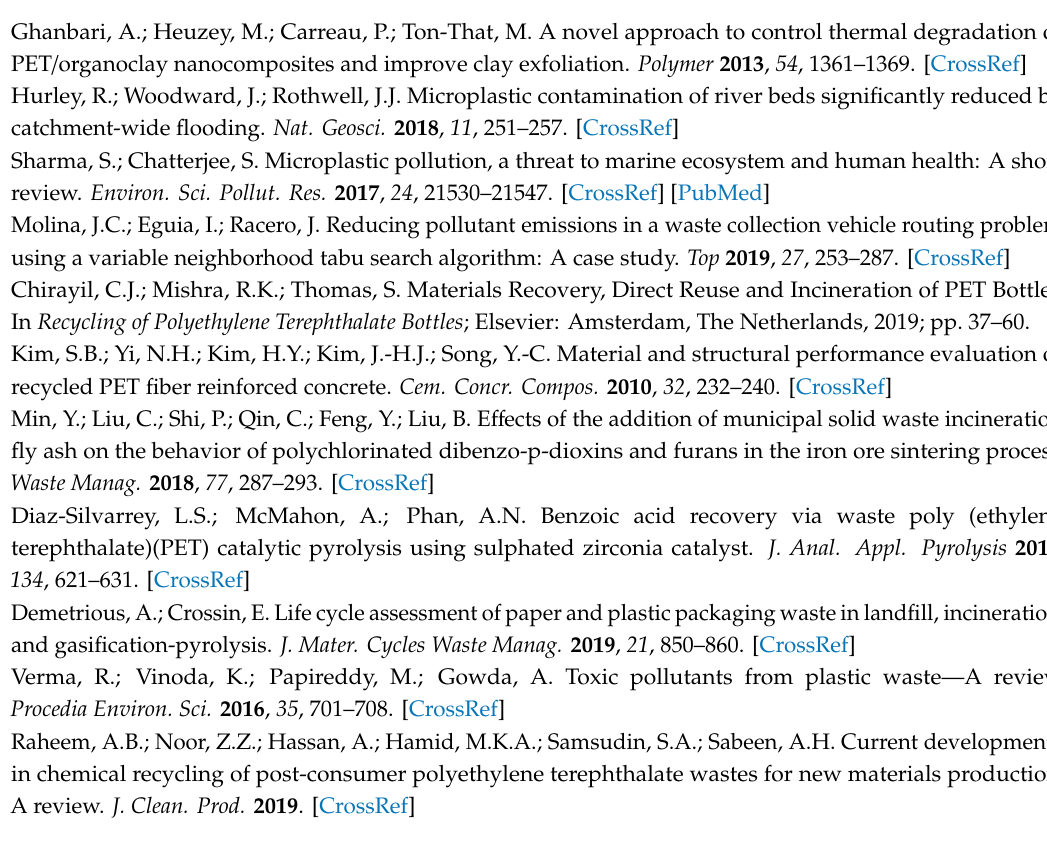
Figure S1: (a) Picture of PET sample (left) and slab which is cut into squares (right); (b) Chemical structure of PET, Figure S2: Change in PET weight during TGA, Table S1: The component of polycyclic hydrocarbons, biphenyl derivatives and amine species obtained from pyrolysis of